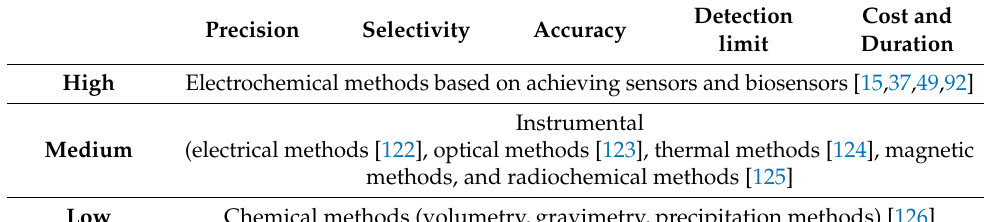
Table 6. Performance criteria of the methods developed for the detection of